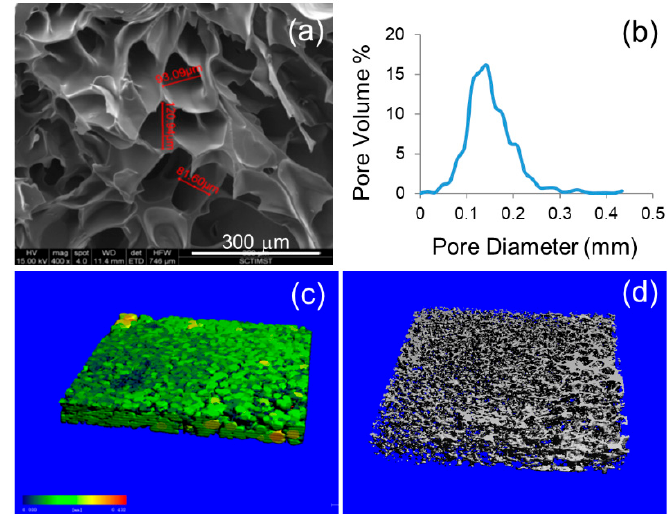
Figure 2. Morphological analysis of ADA–Gel–PRP hydrogel: ( a ) scanning electron microscope (SEM) and ( b – d ) micro-CT analysis reveal the highly interconnected porous nature of the hydrogel, with a uniform pore size and pore size distribution.